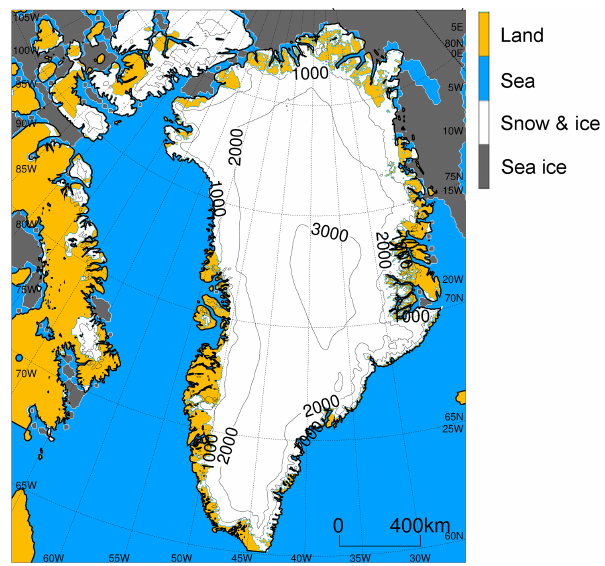
Figure 1. Model domain of NHM–SMAP used in this study show- ing surface types (colors). The sea ice pattern is depicted for 1 July 2012, and it changes from day to day. Contours on ice sheets and ice caps indicate surface elevation (contour interval